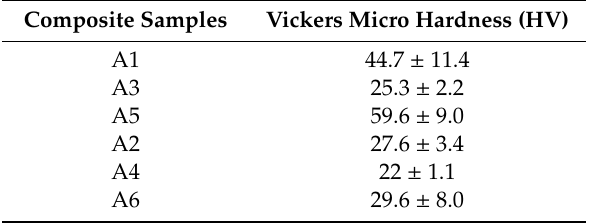
Table 4. Micro hardness properties of GF / SF / CTS composite sca ff olds in terms of mean ± SD. Composite